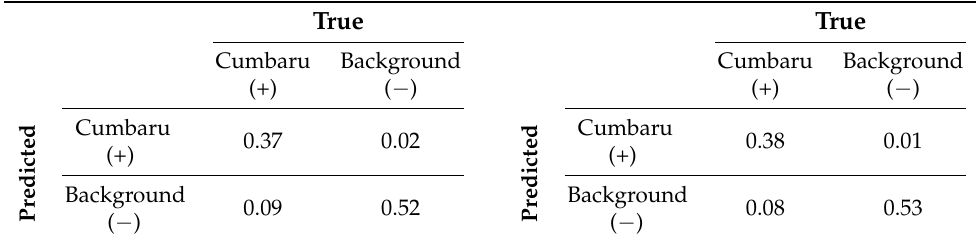
Table A4. Confusion matrix for the DeepLabv3+ Xception version without CRF (left) and with CRF (right). The values are normalized by the total of